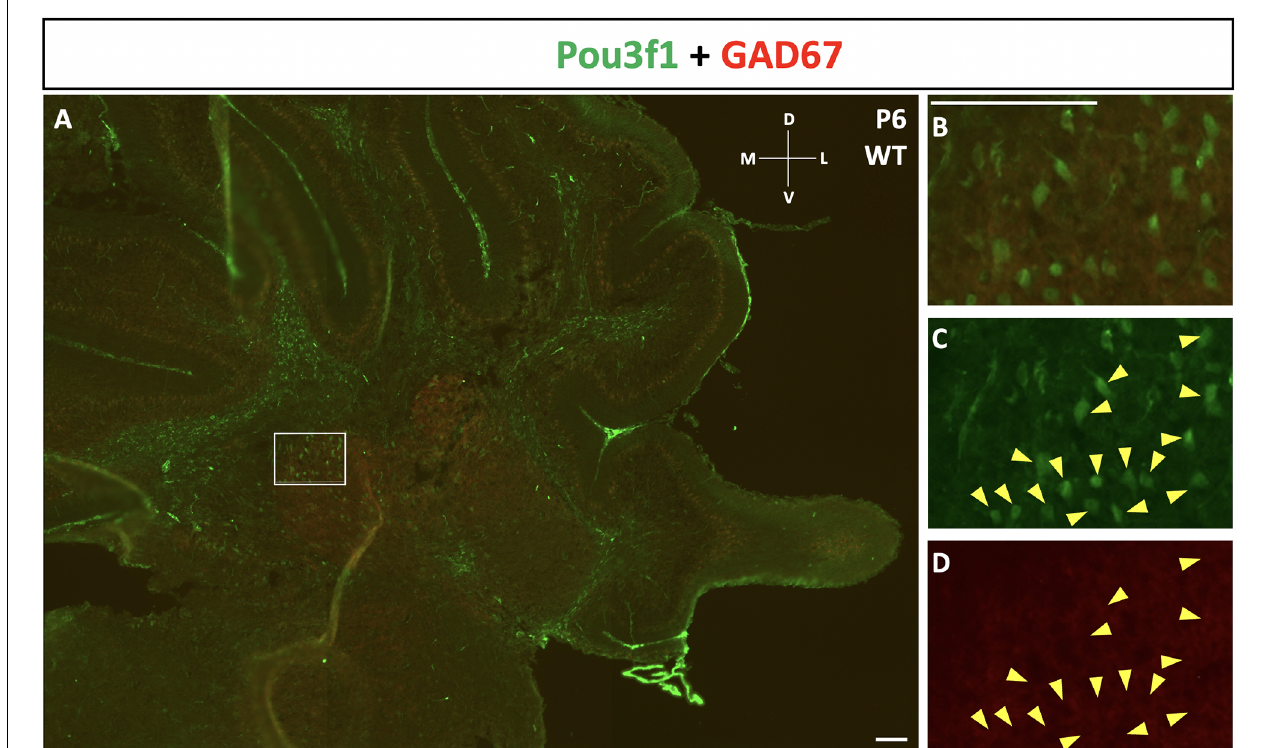
FIGURE 3 | The lack of co-expression between Pou3f1 (green) and GAD67 (red). (A) A representative P6 coronal cerebellar section showing the relative expression patterns of Pou3f1 and GAD67, and the absence of co-expression between the two molecules. (B–D) Within the cerebellar white matter, Pou3f1 + cells are not surrounded by GAD67 puncta, demonstrating that they are not GABAergic. Panel (B) shows merged green and red channels, while (C) and (D) show individual channels. D, dorsal; L, lateral; M, medial; V, ventral. Scale bars, 100 µ